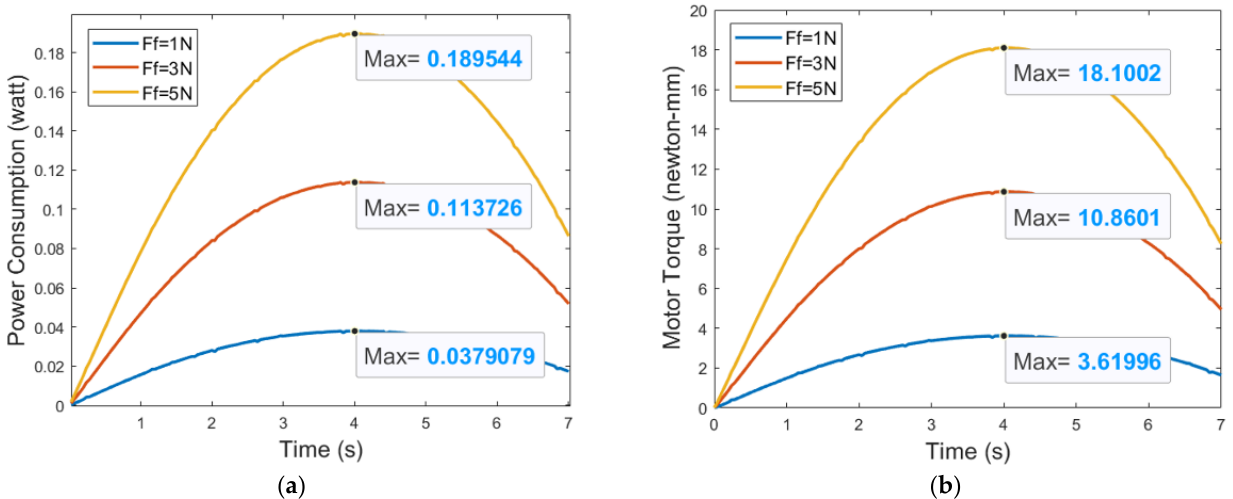
Figure 9. A-AFiM performance simulation: ( a ) Power consumption, and ( b ) Motor torque.